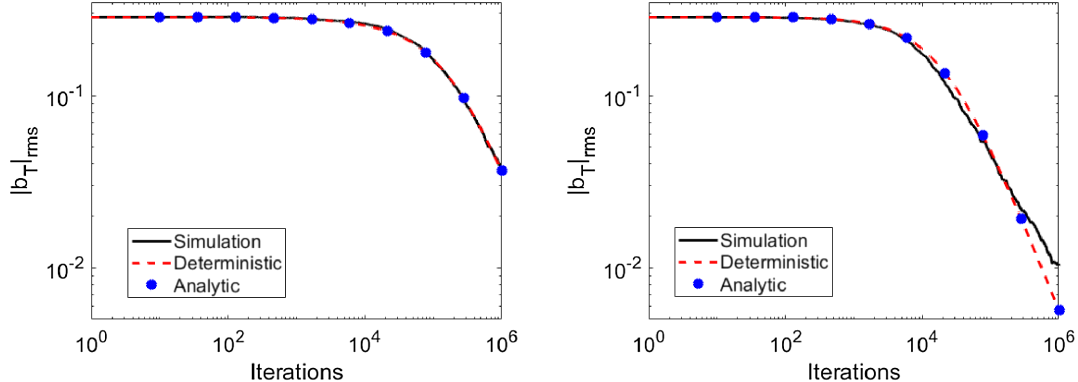
FIG. 8. Left: the discrepancies j b T j rms calculated by direct numerical simulation (black line), from Eq. (12) (red dashes), and from Eq. (18) (blue dots) for σ w ¼ 0 . 1 mm and no dither. Right: with 20 μ rad round-robin dither added.